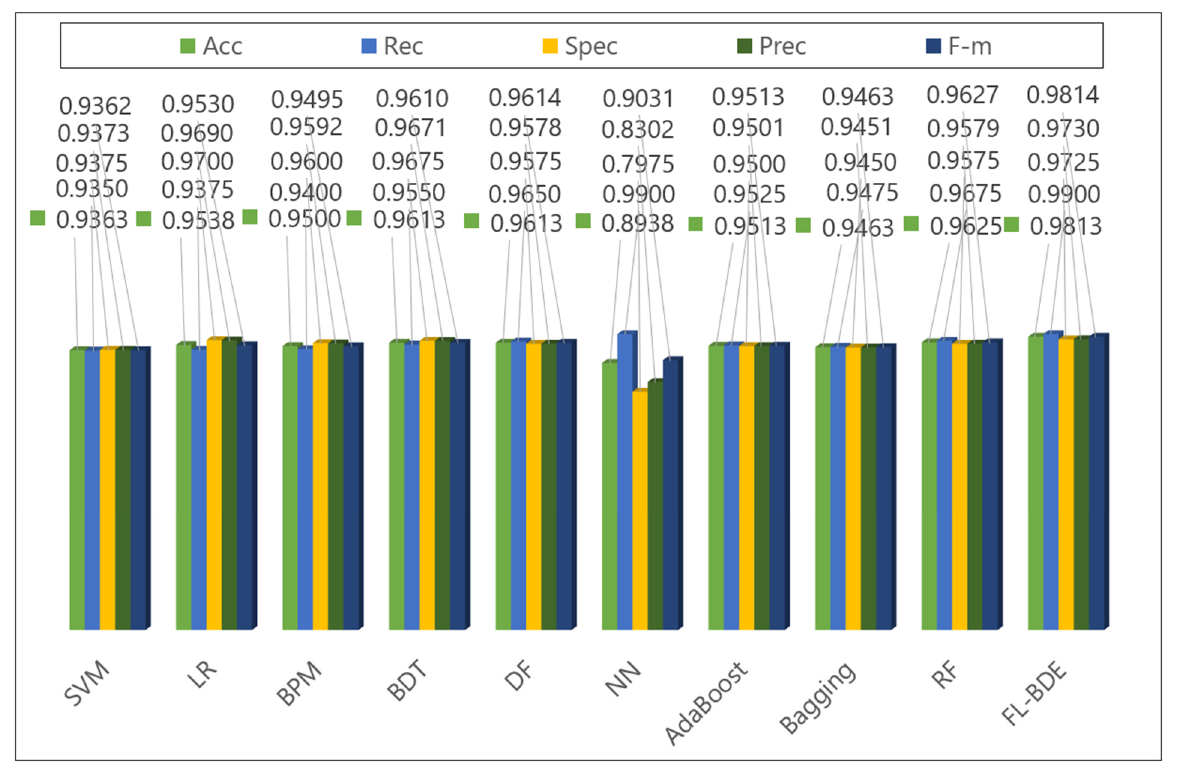
Figure 4. Performance results of FL-BDE, ML- and EL-based models at the split ratio of 0.60.